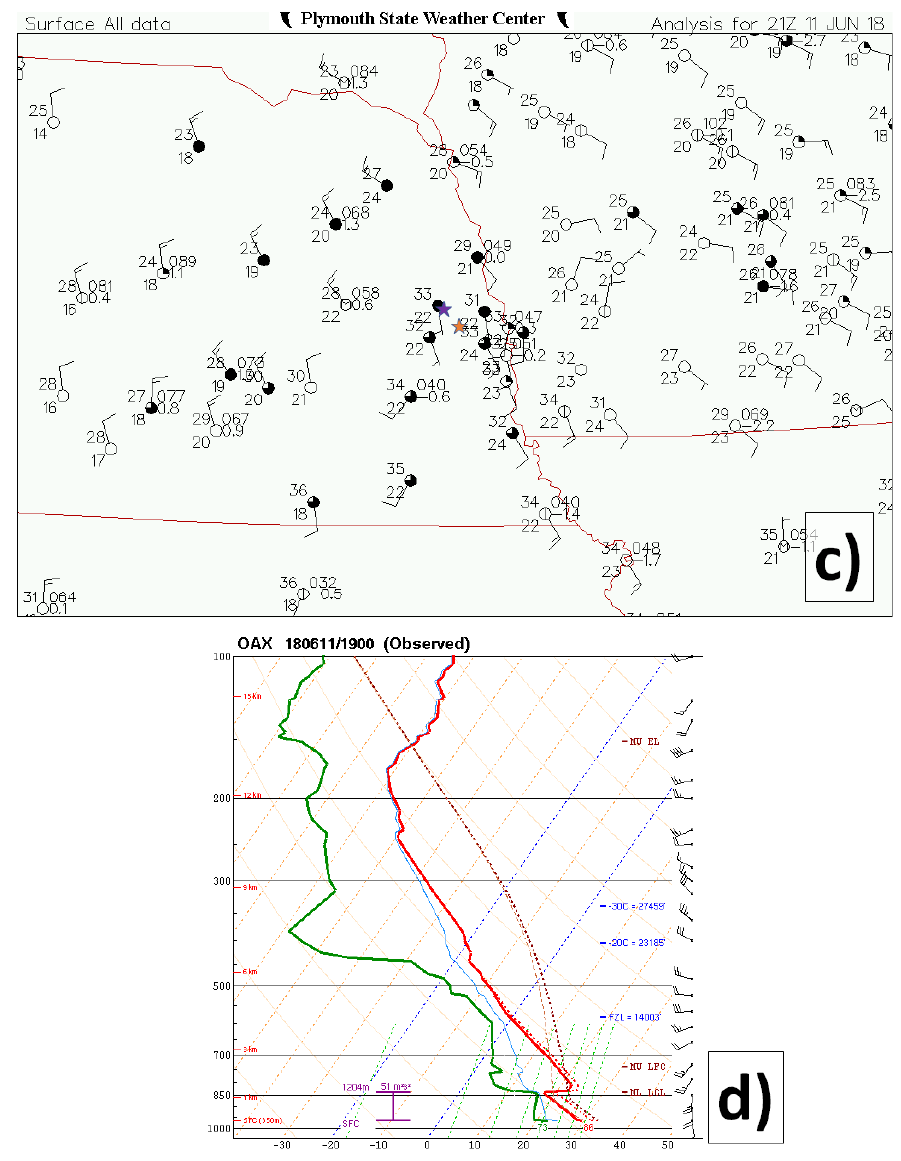
Figure 2. Environmental data representative of the 11 June 2018 supercell. ( a ) 300 hPa observations from 00 UTC 12 June 2018; ( b ) 700 hPa observations from 00 UTC 12 June 2018; ( c ) surface station observations from 21 UTC on 11 June 2018 (all temperature values are in °C and data locations around the station plot are standard); and ( d ) sounding from KOAX taken at 19 UTC 11 June 2018 in the unstable environment east of the advancing cold front. Purple star in eastern Nebraska (panels a and b) indicate approximate radar/disdrometer site. In panel (c), the purple star is the disdrometer location and the orange star is KOAX location. Panels (a), (b), and (d) courtesy of the Storm Prediction Center; panel (c) courtesy of Plymouth State University.